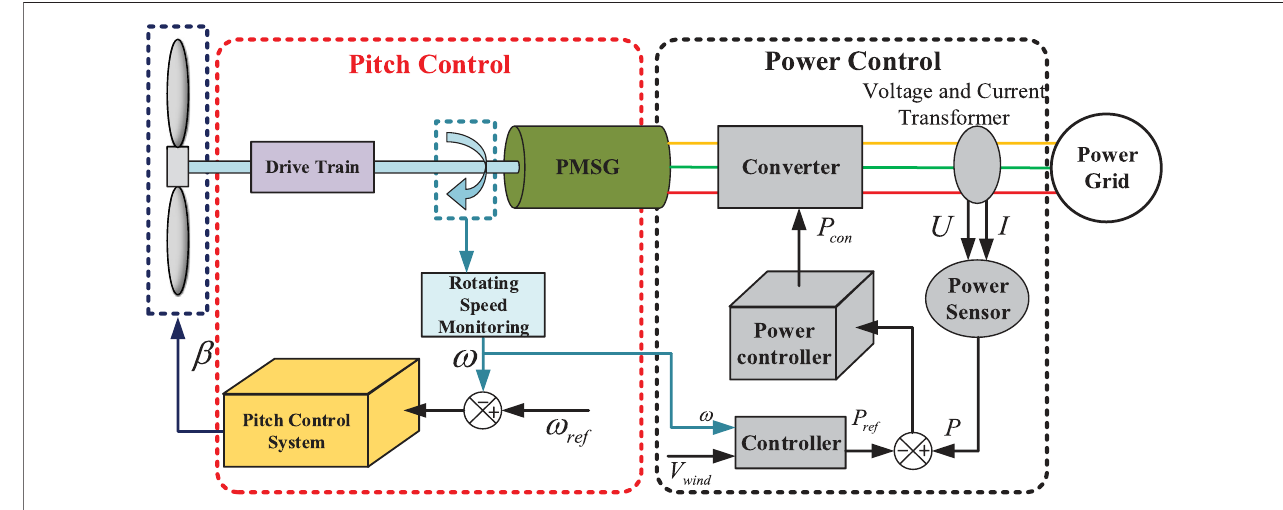
FIGURE 1 | Schematic diagram of the wind turbine control system.